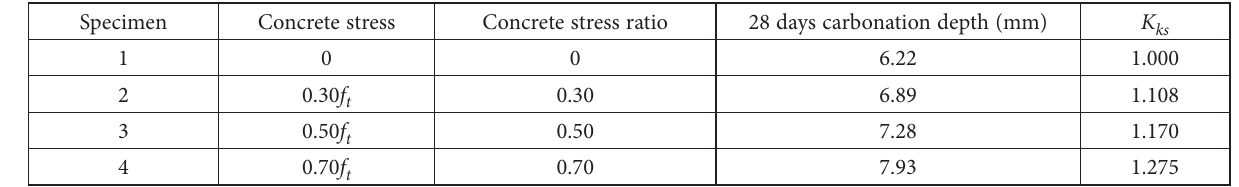
Table 5. Carbonation depths of specimens under different concrete stress conditions (data from Wu, 2009) Specimen